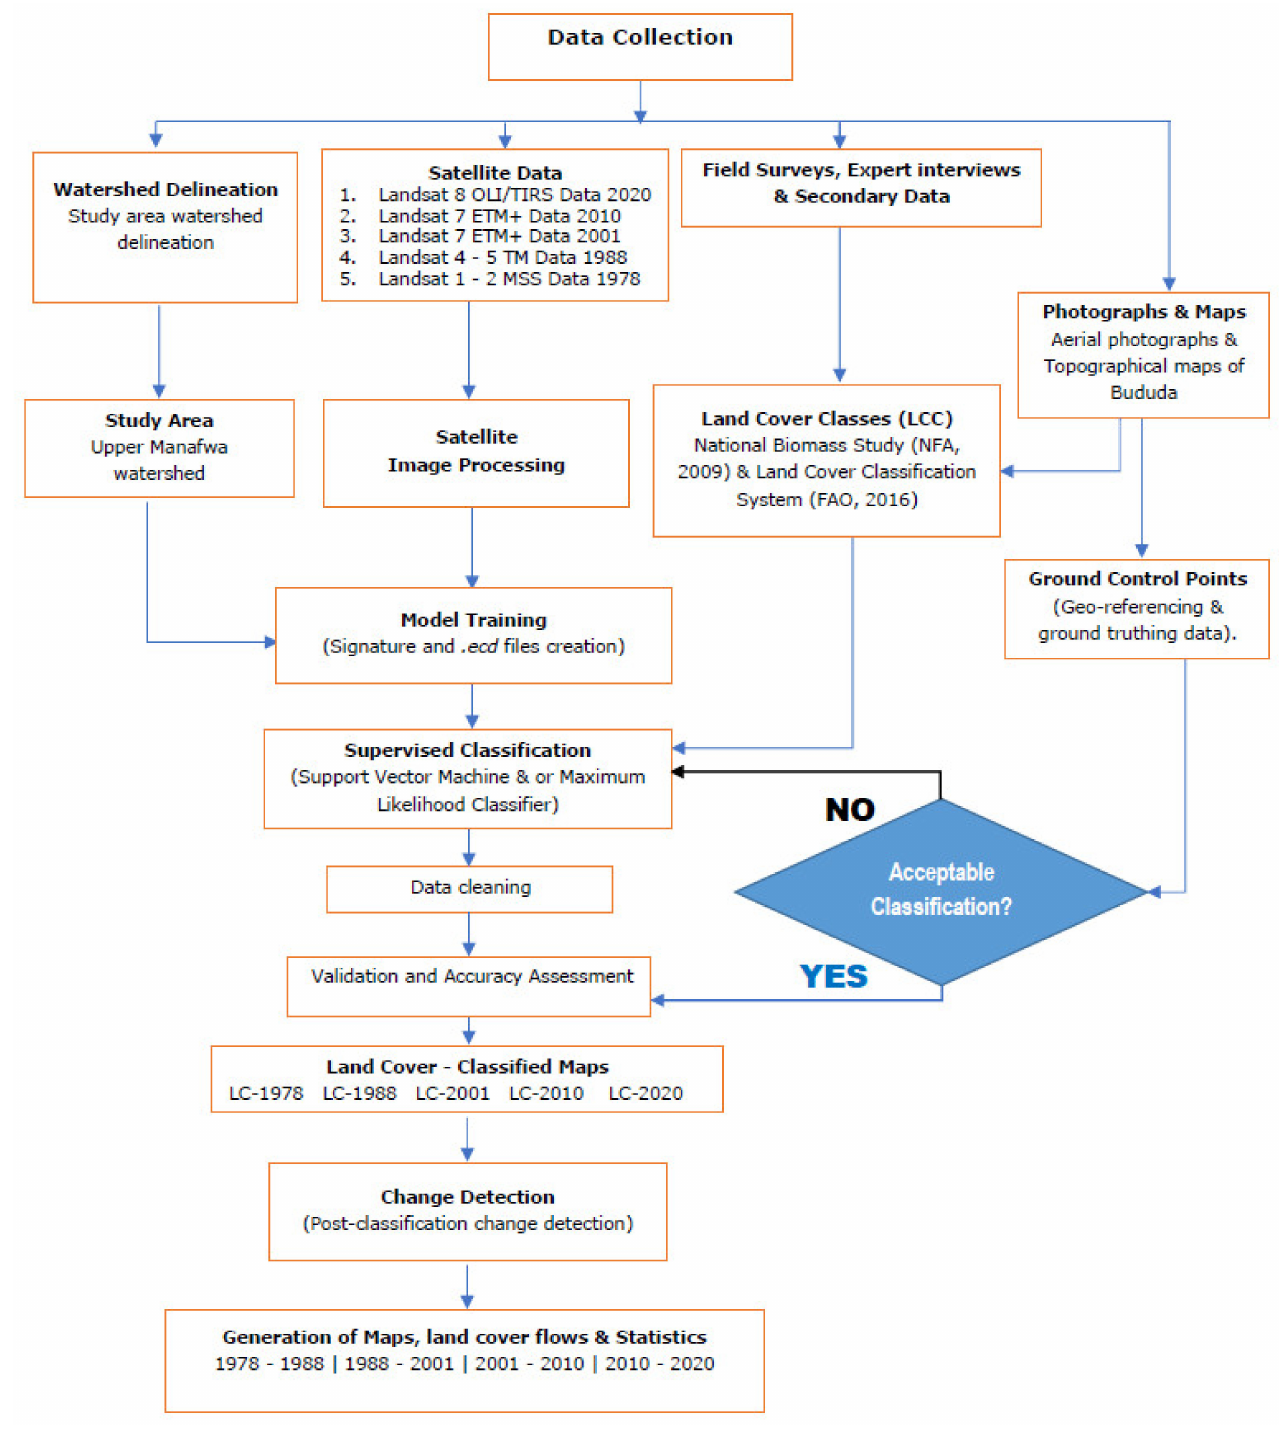
Figure 3. Flow chart for analysis of the land cover change detection in upper Manafwa